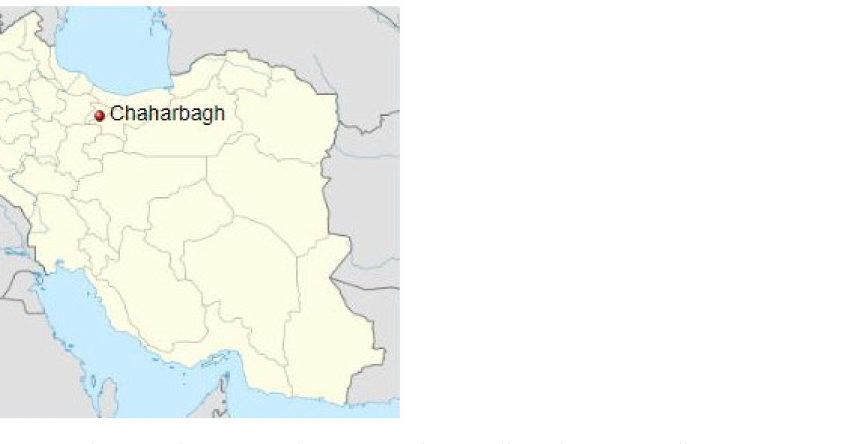
Figure 5. Map showing the region where material was collected in Karaj, Alborz Province,